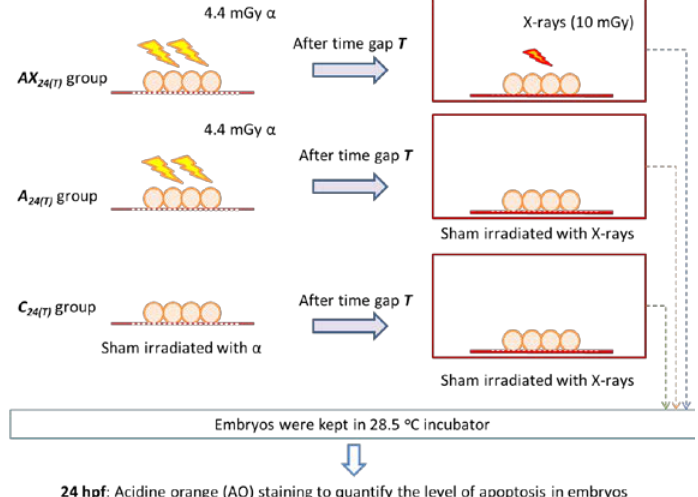
Figure 4. Schematic diagram showing the experimental steps involving embryos in the AX 24(T) , A 24(T) , and C 24(T) groups, where time gaps T = 0, 10, 15, 30, or 60 (min) between alpha-particle and photon irradiations.